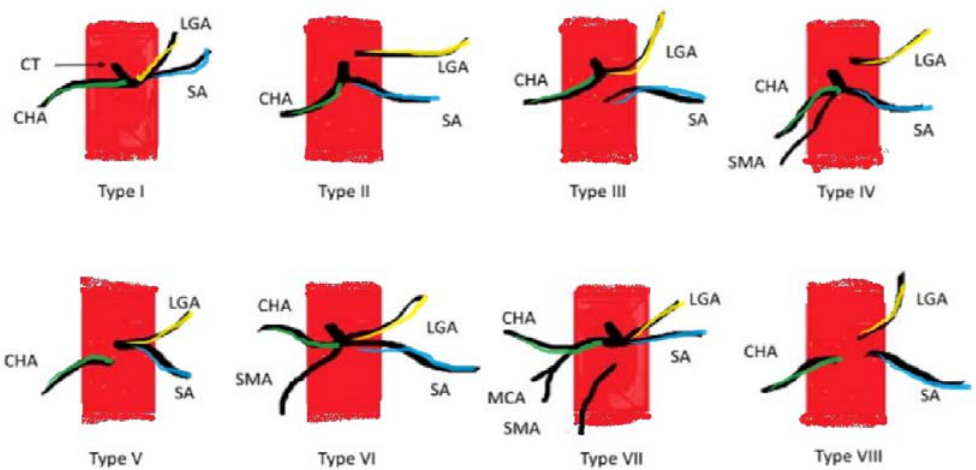
Figure 4. A scheme of types of coeliac trunk variations according to Uflacker’s classification. CT—coeliac trunk, CHA—common hepatic artery, LGA—left gastric artery, SA—splenic artery, SMA— superior mesenteric artery, MCA—middle colic artery.